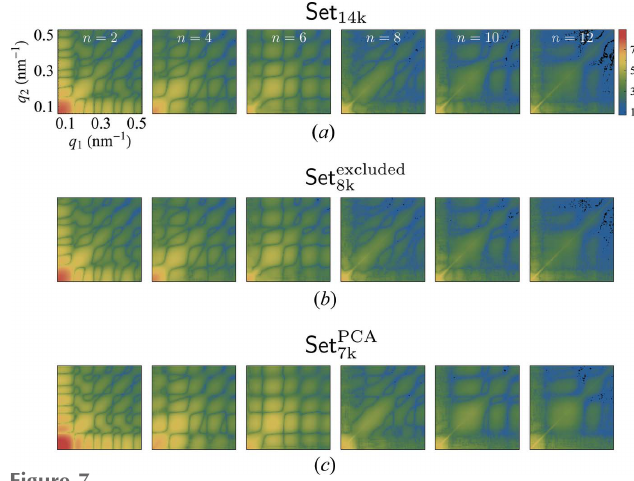
Figure 7 Correlation maps of the amplitudes j e CC n ð q spectra Fourier components. ( a ) Set 14k and ( b ) Set 8k excluded have very similar features which suggests that Set 8kexcluded with presumably non-single hits dominates the properties of Set 14k . ( c ) Set 7kPCA consists of the PCA single-hit selection and shows more pronounced features.